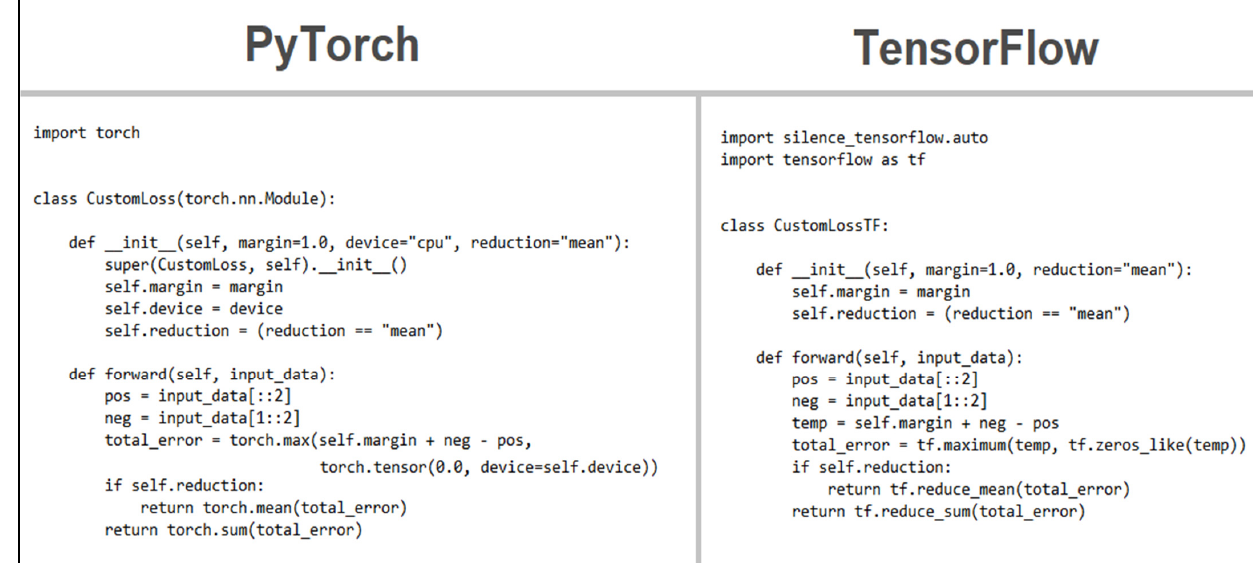
Figure 7. Loss function comparison.